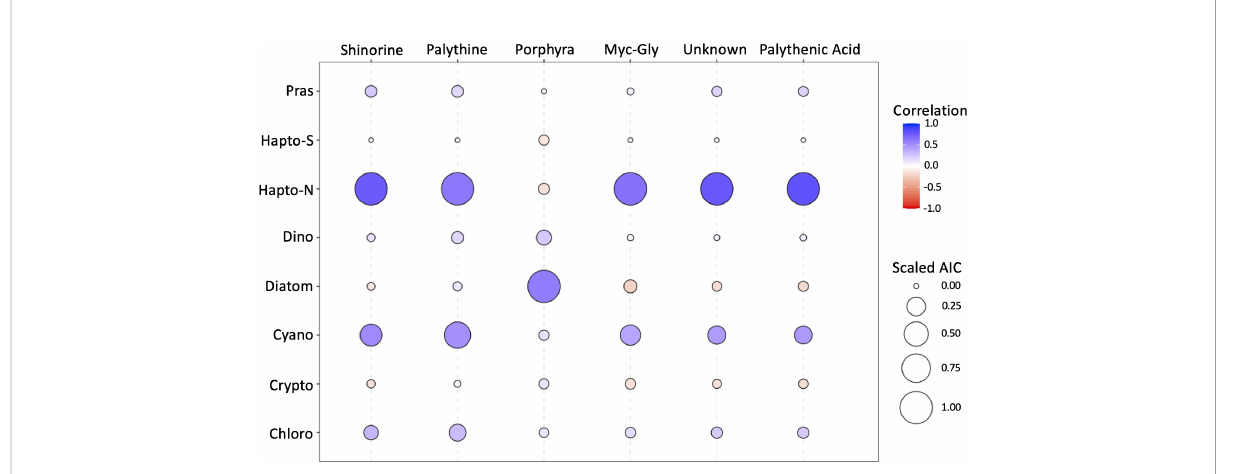
FIGURE 6 Pearson correlation coef fi cient and scaled Akaike information criterion (AIC) between taxonomic and MAA fractions.